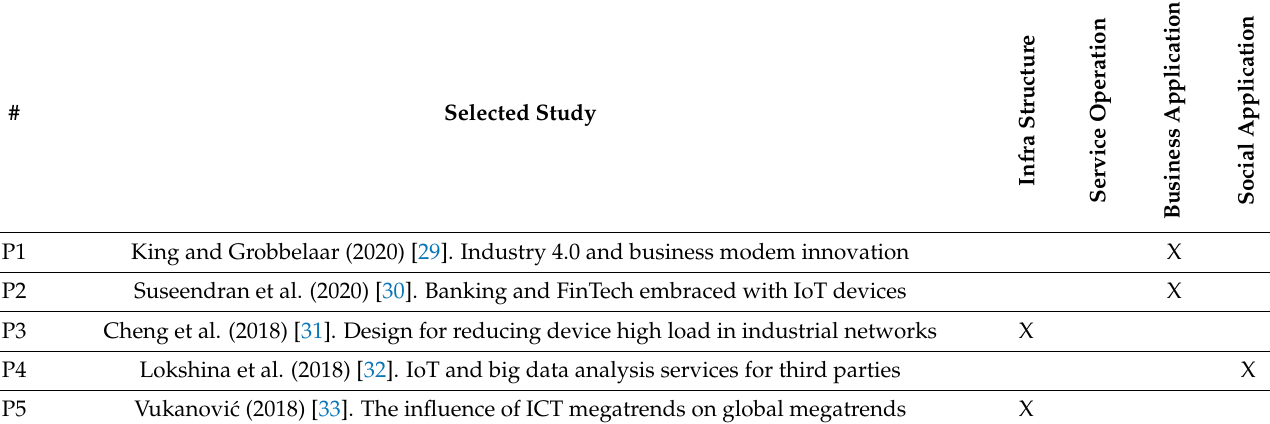
Table 2. List of selected studies by topic